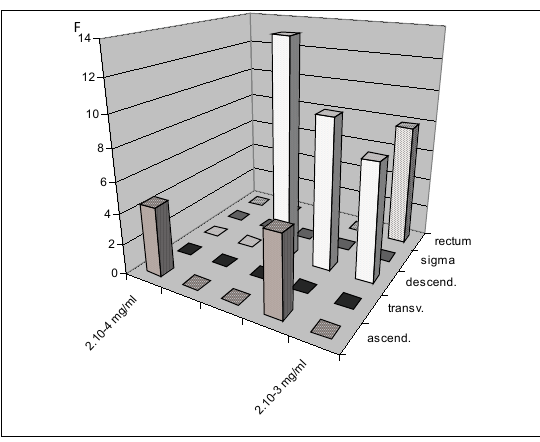
Figure 2. Comparison of the strength of the isometric registered inhibitory effects of drotaverine against hyoscine for amplitude of the spontaneous phase contractions of SM colon samples. Every bar shows the degree of dominance of the drotaverine induced effects against hyoscine induced effects. The absence of bars shows drug concentrations where there is no difference between the effects of the